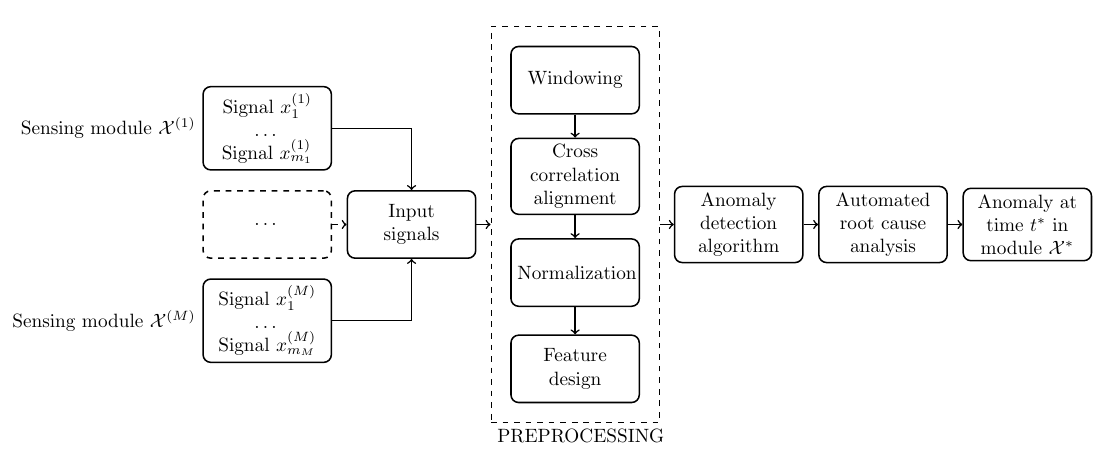
Figure 2. AD4MPFM: Flowchart of the proposed algorithm for anomaly detection of Multiphase Flow